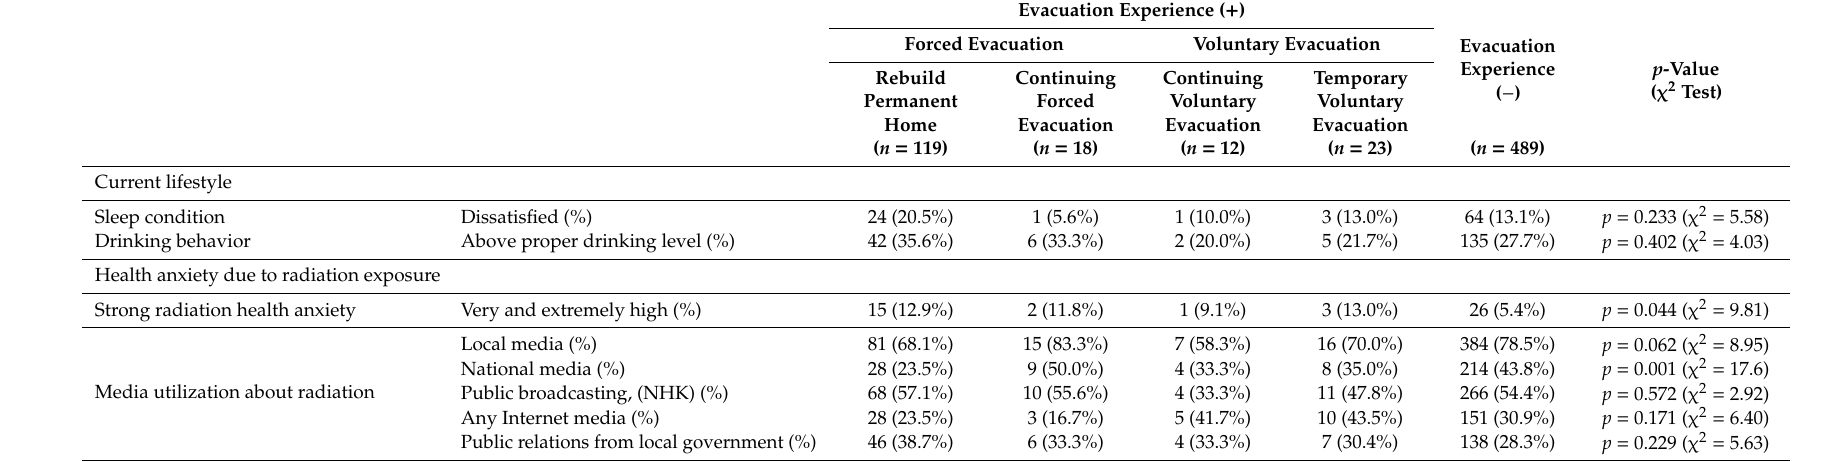
Table 2. Current lifestyle, strong radiation health anxiety, and media utilization about radiation.